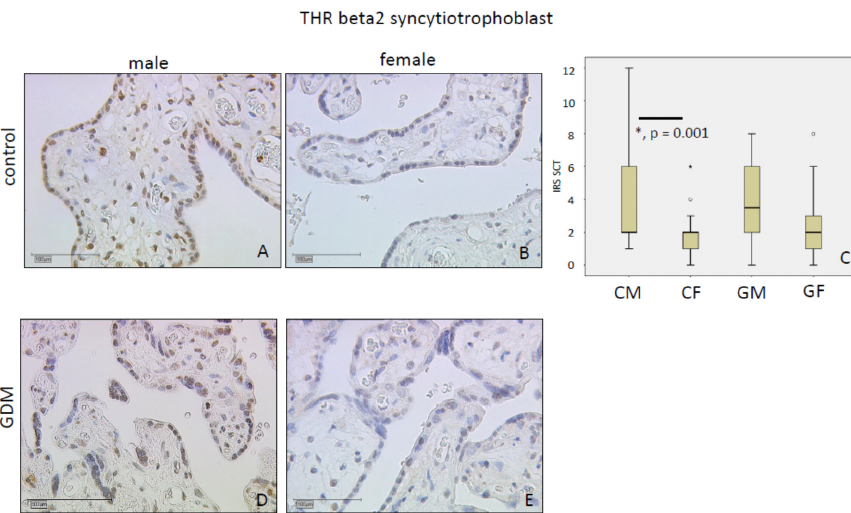
Figure 5. THR β 2 immunoreactivity with low intensity in control SCT ( A , B ) and GDM ( D , E ). IRS for each group are shown as box plots for SCT (IRS SCT) ( C ). The boxes represent the range between the 25th and 75th percentiles with a horizontal line at the median. The circles indicate values more than one and a half box lengths, and the asterisk values more than three box lengths from the 75th percentile. Groups are labelled as follows: CM = control male; CF = control female; GM = GDM male; GF = GDM female. Scale bar = 100 µm.